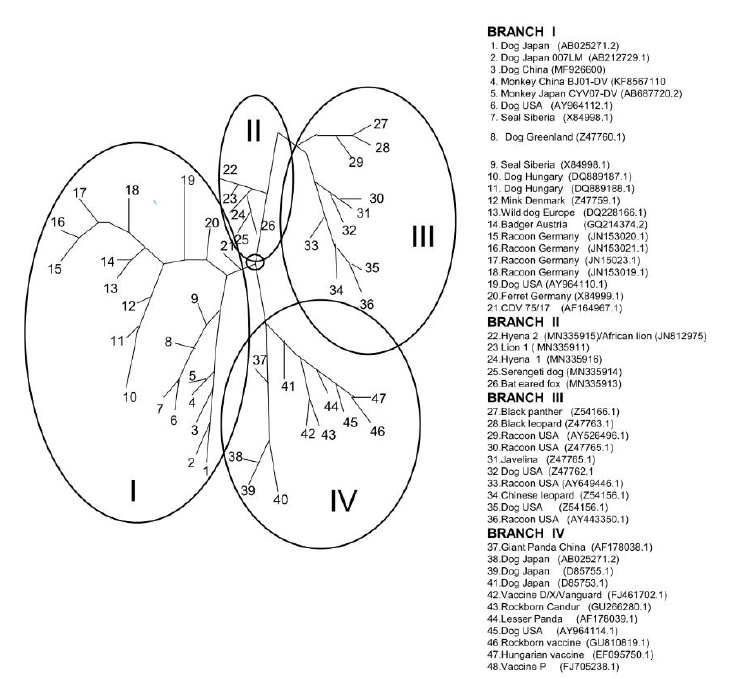
Figure 2. Phylogenetic relationship of CDV strains from the 1993 / 1994 Serengeti epidemic to related viruses based on H gene sequences. Circles represent branches (I, II, III and IV) from a common node (black circle). Accession numbers are given for isolates in the figure key. Associated references where available for viruses as numbered in the key: 1, 37. Mochizuki et. al. [72]; 2. Lan et al. [73]; 3. Qiu et al [56]; 4. Feng et al. [71]; 5. Sakai et al. [57]; 6, 8, 12, 29, 30, 31, 34. Bolt et al. [74]; 7. 20. Mamaev et al. [5]; 8, 9, 10. 11 Demeter et al. [75]; 12. Martella et al. [62]; 14,15,16,17 18. Nikolin et al. [76]; 19, 43 Pardu et al. [66]; 21, Weiderkehr et al (unpublished); 22(Hyena)-24 Current report; 22 (lion). Nikolin et al. [52], 33. Harder et al. [77]; 28, 32, 35. Lednicky et al. [78]; 38, 39. Iwatsuki et al. [79]; 40. Woma et al. [64]; 41, 44. Martella et al. [80] 29: 1222–1227; 46. Chulakasian et al. [81]. Unrooted neighbor-joining phylogenetic trees were constructed by using the MegAlign version 7.1 package (DNASTAR, www.dnastar.com) with the ClustalW method (www.clustal.org).